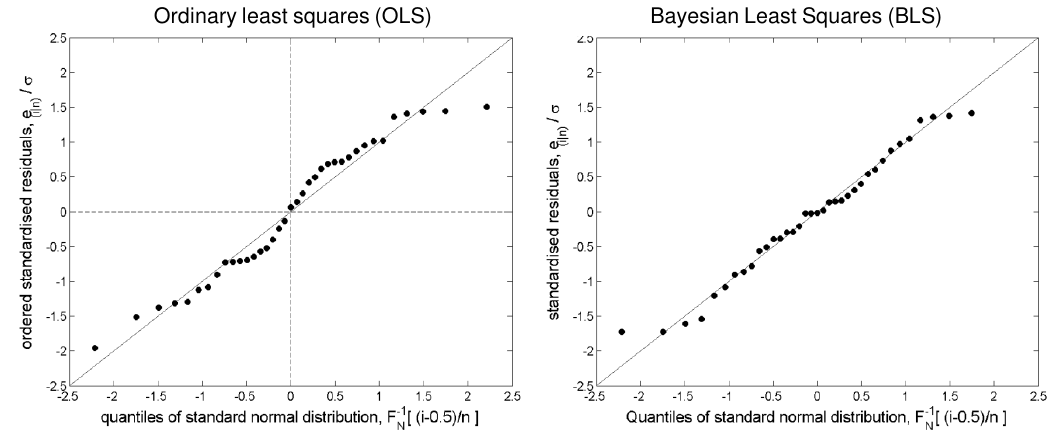
Figure 24: Quantile-quantile (QQ) plots for (left) OLS and (right) BLS regressions of the 𝐼𝐷𝑉 index and the IMF strength 𝐵 . These plots are used to check if the distribution of fit residuals is Gaussian, as assumed by least-squares fitting procedures. The ordered, standardized residuals Δ 𝐵 𝑖 /𝜎 (where 𝜎 2 = Σ 𝑖 Δ 𝐵 2 and 𝑛 is the number of samples) are shown as a function of the corresponding quantiles of a standard normal distribution. Deviations from the line of slope 1 shown reveal departures from a normal distribution of standard distribution 𝜎